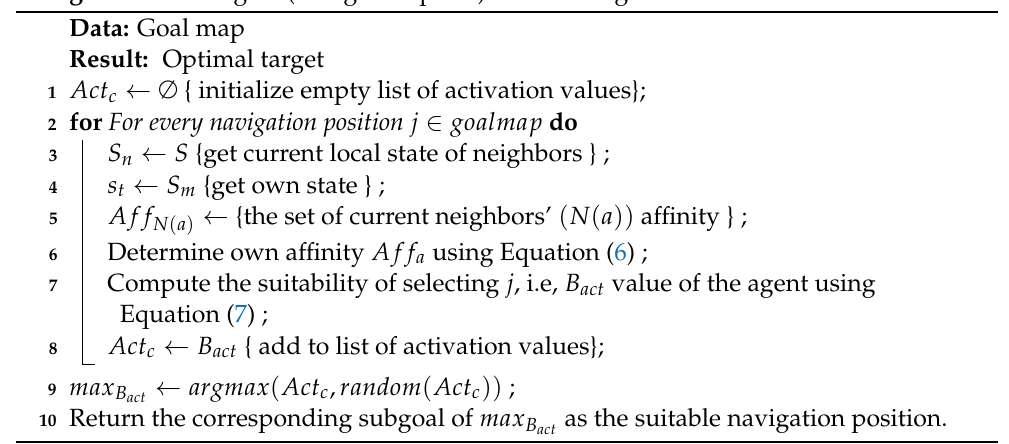
Algorithm 1: Subgoal (navigation point) selection